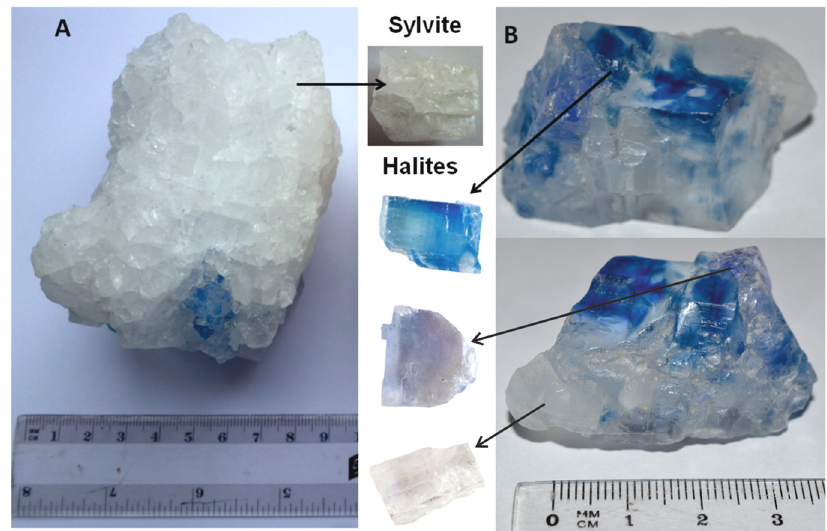
Figure 3. Examples of samples of investigated minerals: ( A ) aggregates of the blue halite between sylvite vein, ( B ) aggregates of the blue, purple and colorless halite; Kłodawa diapir, Poland.